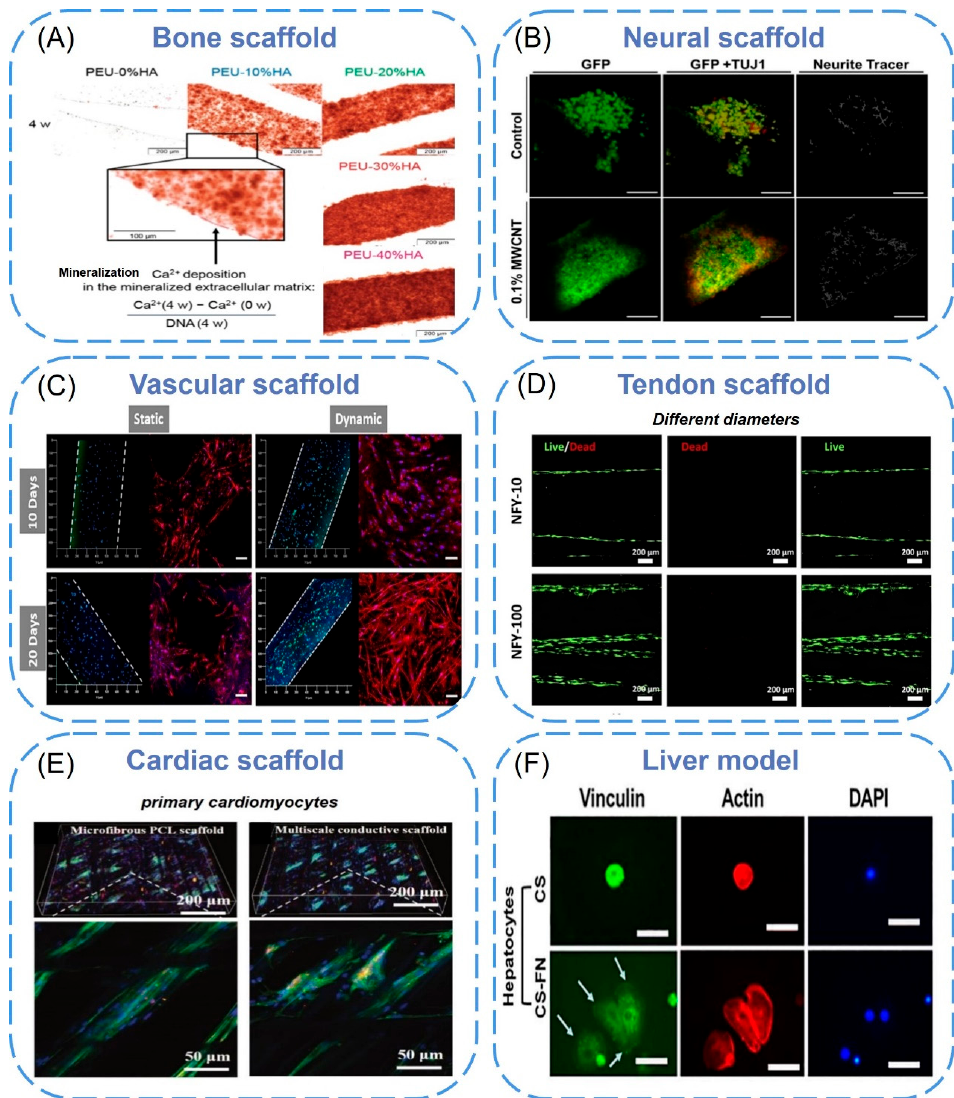
Figure 5. ( A ) Ca 2+ deposited in the mineralized ECM on the surface of the filament in the scaffolds as visualized by Alizarin Red S staining. Dark red layers on the surface of the filaments in the bright field microscope image indicated enhanced mineralization resulting from higher HA contents in the scaffolds [120]. Copyright 2017, American Chemical Society. ( B ) Confocal micrographs of neural stem cells growth and spreading on 3D printed scaffolds at day 8. Cells were stained with GFP (green) and TUJ1 (red) [123]. Copyright 2018, IOP Publishing Ltd. ( C ) hMSCs (bone scaffolds, right columns) and HUVECs (blood vessel scaffolds, left columns) co-cultured, where the white dash lines indicate blood vessel channels [127]. Copyright 2021, Elsevier. ( D ) Fluorescence imaging of live (green) and dead (red) TSPCs that were seeded on aligned NFYs and cultured in a growth me ‐ dium for 24 [128] . Copyright 2022, Frontiers Media S.A. ( E ) Immunofluorescence images of primary cardiomyocytes on the microfibrous PCL scaffolds and multiscale conductive scaffolds after eight days of culturing [133] . Copyright 2019, RSC Pub. ( F ) Vinculin focal adhesion and F ‐ actin distribu ‐ tion of hepatocytes cultured on 2D chitosan or chitosan ‐ FN film surfaces [134] . Copyright 2017, Wiley.